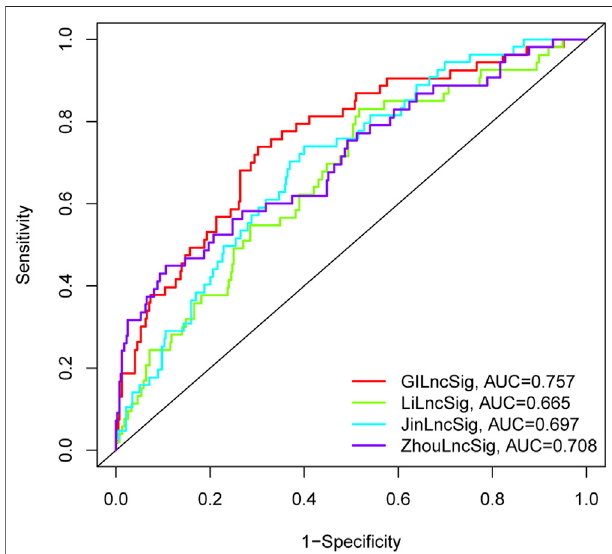
FIGURE 7 | Performance comparison of the GI-lncRNA-based model with existing lncRNA-based prognostic models for LUAC. The receiver operating curves for the new prognostic model and the recently published lncRNA-based models for predicting the prognosis of LUAC patients.